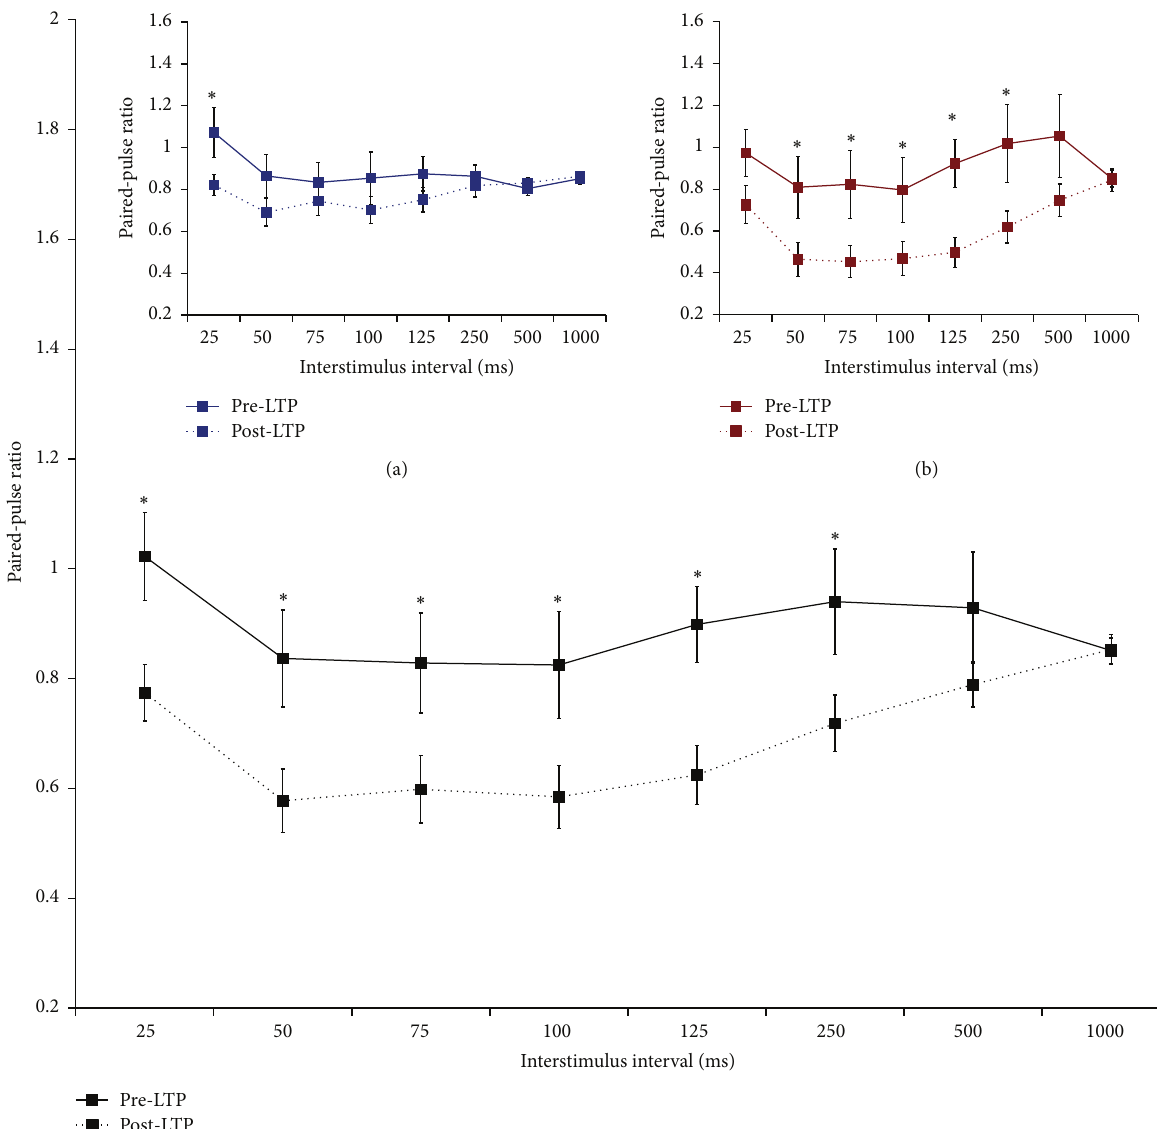
Figure 5: The effect of LTP induction on paired-pulse responses; data are collapsed across rearing conditions. LTP induction resulted in significant enhancement of PPD at ISIs of 25 to 250 ms. ANOVA results: effect of ISI, F (2.34, 39.85) = 4.16, 𝑃 < 0.05 ; effect of LTP induction, F (1.00, 17.00) = 11.11, 𝑃 < 0.05 ; effect of ISI by LTP interaction, F (3.38, 57.48) = 4.14, 𝑃 < 0.05 . Inserts (a) and (b) show the effect of LTP for control and WN-reared rats, respectively; ∗ indicates significant simple effects, 𝑃 < 0.05